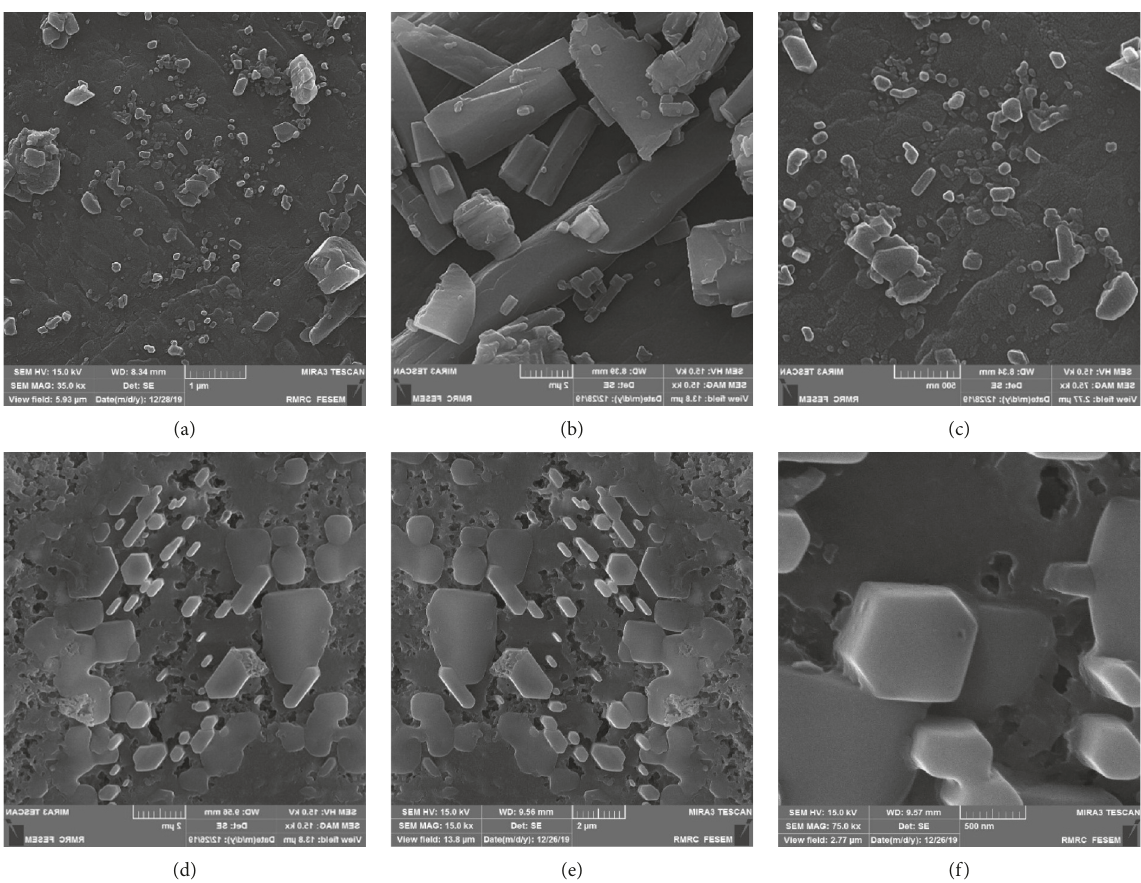
Figure 2: FESEM images of (a–c) SPTand (d–f) SPT-T-G at diverse scale bars. Red arrows show amorph particles, and blue ones show well-resolved cubic nanostructures.